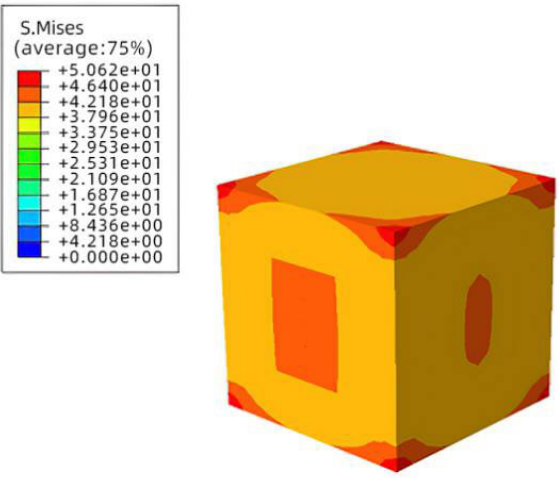
Figure 13. Stress cloud diagram of specimen subjected to Z-axis loading compression.